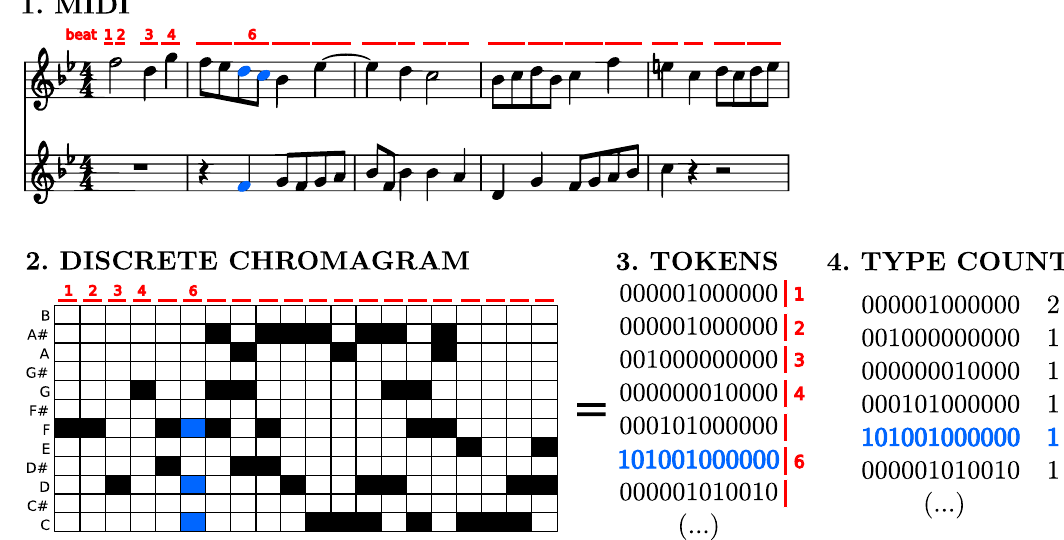
Figure 1. Scheme showing the correspondence between a score (represented by two parallel staves) and its representation in terms of discretized chromas. Counts for each type (number of tokens) are also